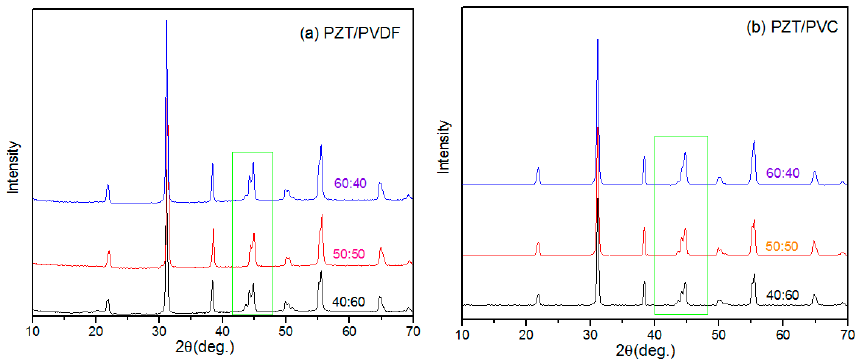
Figure 1. ( a ) XRD pattern of PZT/PVDF composites; ( b ) XRD pattern of PZT/PVC composites.